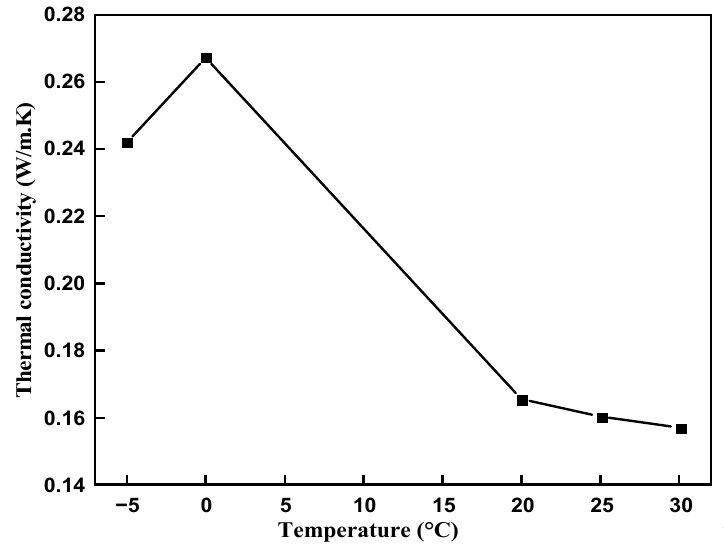
Figure 7. Thermal conductivity of the eutectic PCM at solid and liquid phases. The thermal stability of the eutectic PCM was analyzed by a thermogravimetric analyzer (TGA). The TGA analysis depicts the mass loss (%) with incremental temperature as shown in Figure 8. The decomposition temperatures for caprylic acid and stearyl alcohol were 156.7 ◦ C and 239.8 ◦ C, whereas the decomposition starts at 159.8 ◦ C for the eutectic mixture. However, the decomposition temperature was higher than its melting point temperature, which would not affect its performance during temperature increase due to thermal fluctuation. The TGA analysis shows a wide safe operating temperature range for the prepared eutectic PCM. Therefore, the caprylic acid-stearyl alcohol holds good thermal stability and is safe to utilize for real-time applications.